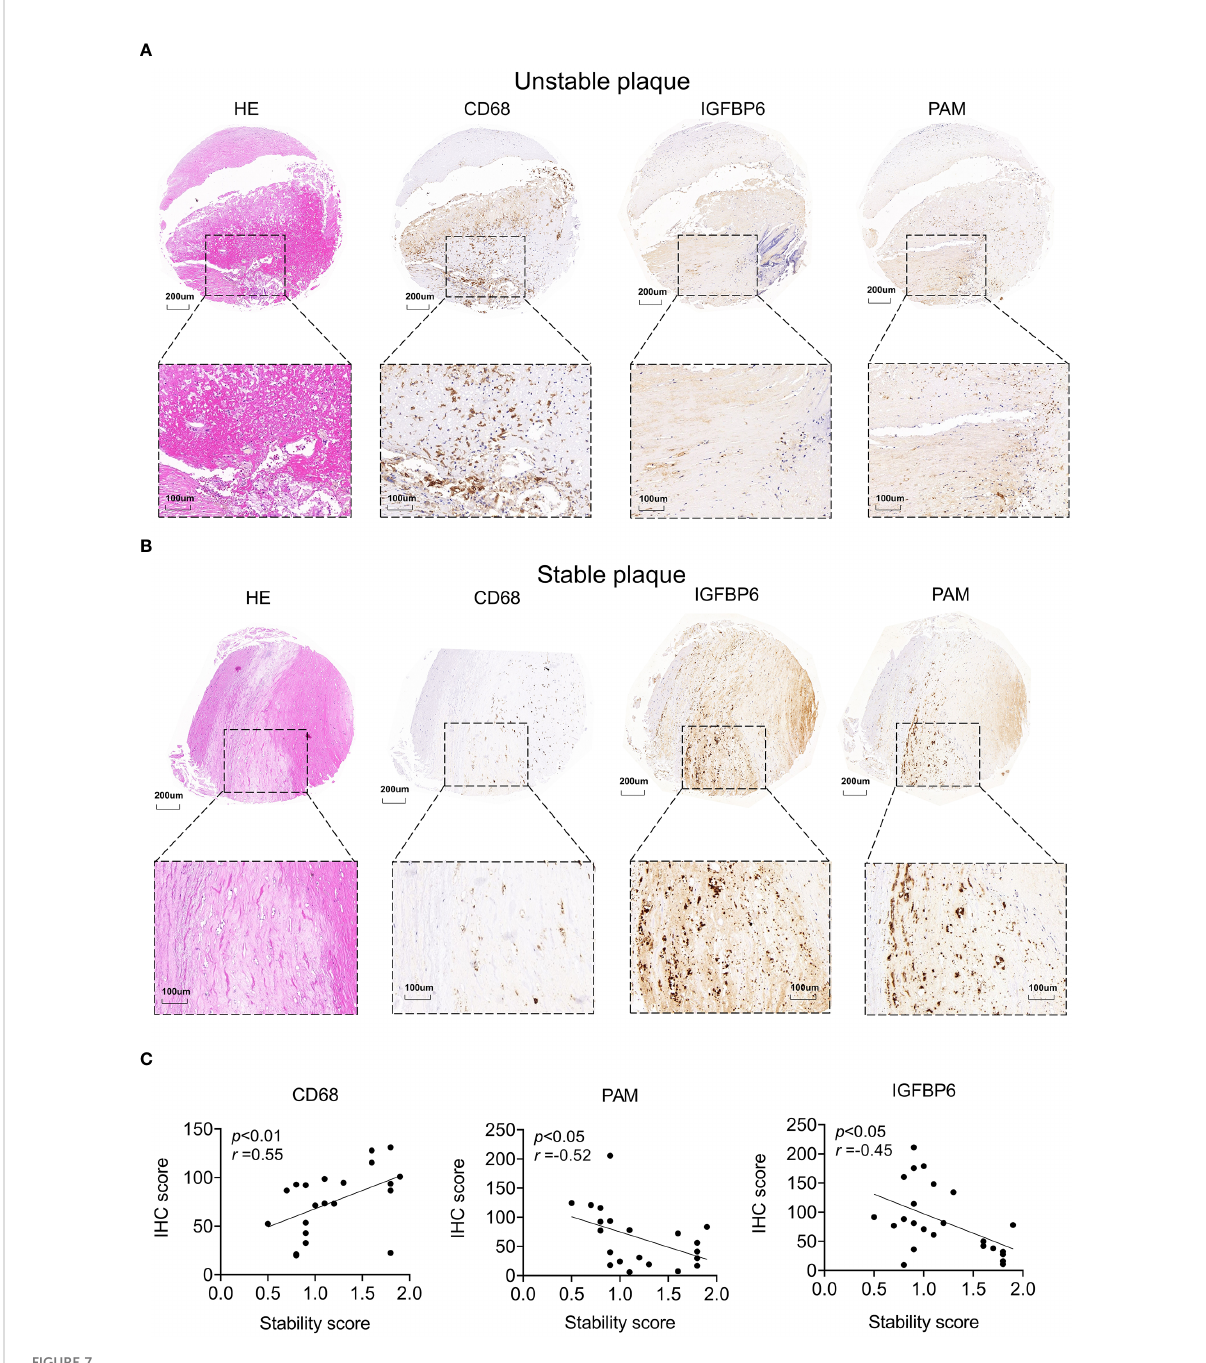
FIGURE 7 Potential biomarkers validated by clinical samples. (A, B) Representative images of hematoxylin – eosin and IHC staining for unstable (A) and stable (B) plaques. (C) Correlation analysis between stability and IHC score in atherosclerotic plaques. The signi fi cance was calculated by Spearman